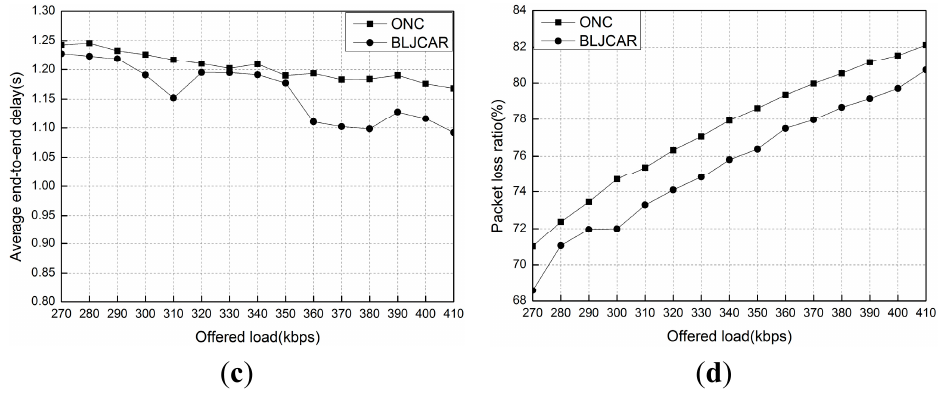
Figure 11. ( a ) Average packet jitter versus offered load; ( b ) Network throughput versus offered load; ( c ) Average end-to-end delay versus offered load; ( d ) Packet loss ratio versus offered